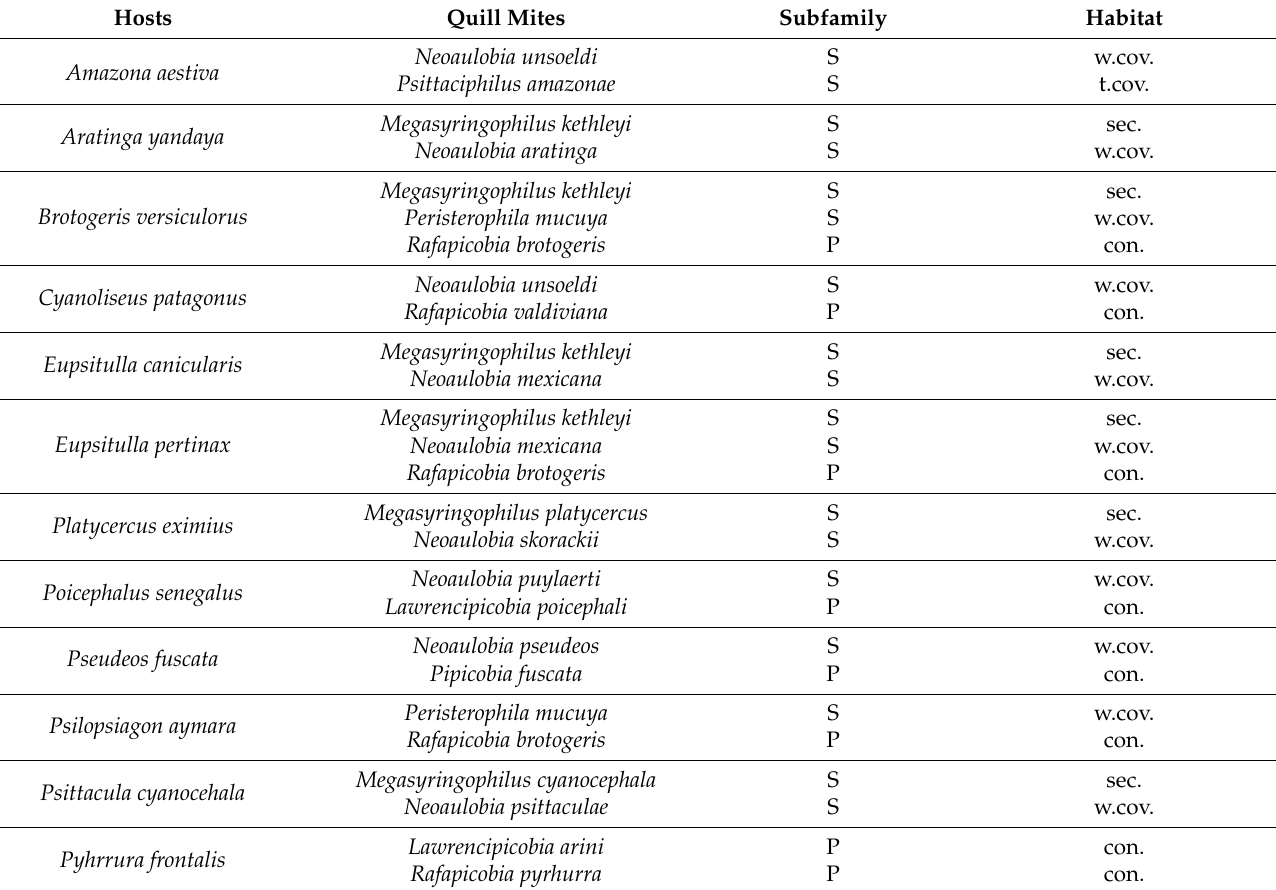
Table 5. Host species infested by two or more syringophilid species with the notation of the habitat